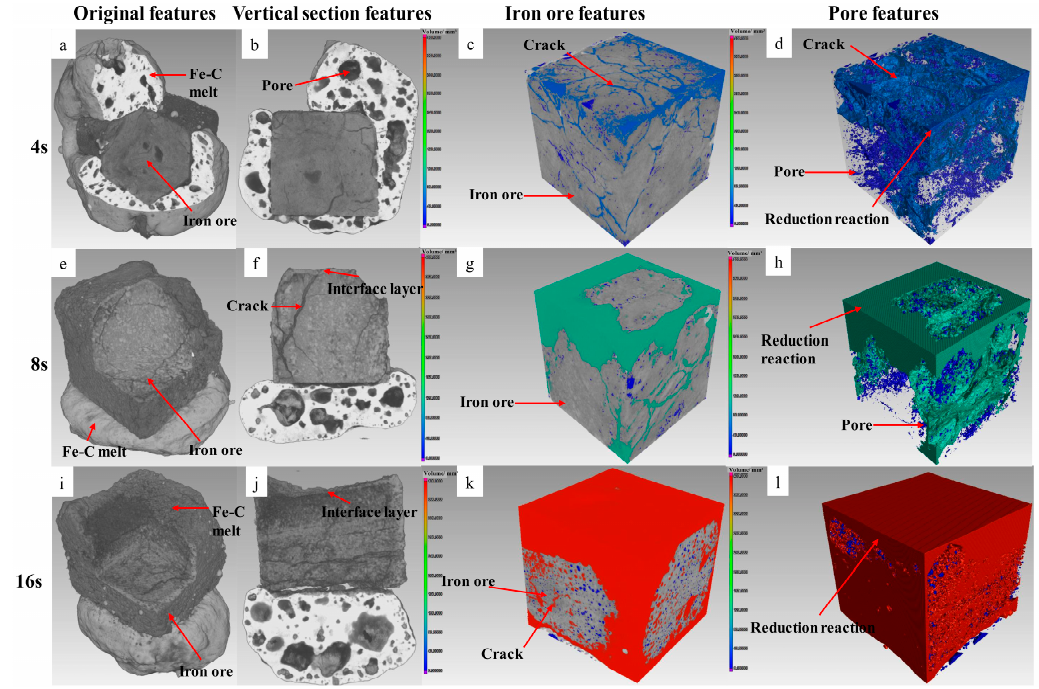
Figure 9. Crack morphology structure evolution of #1 at different smelting reduction moments.